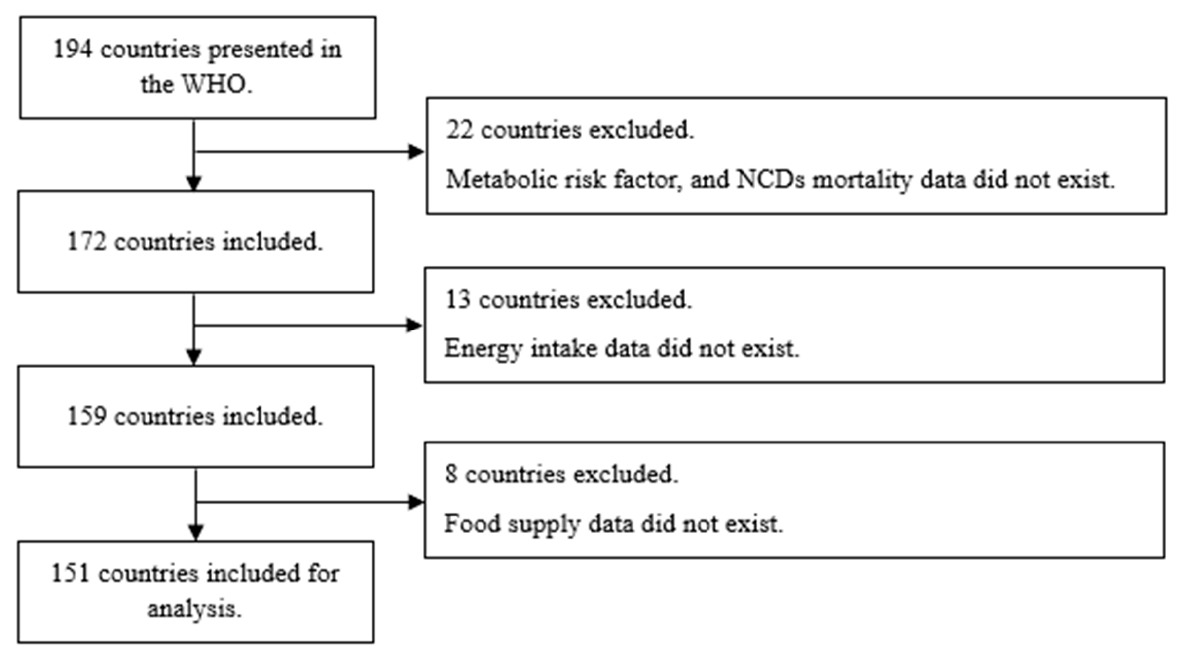
Figure 1. The flow diagram of selection between countries.